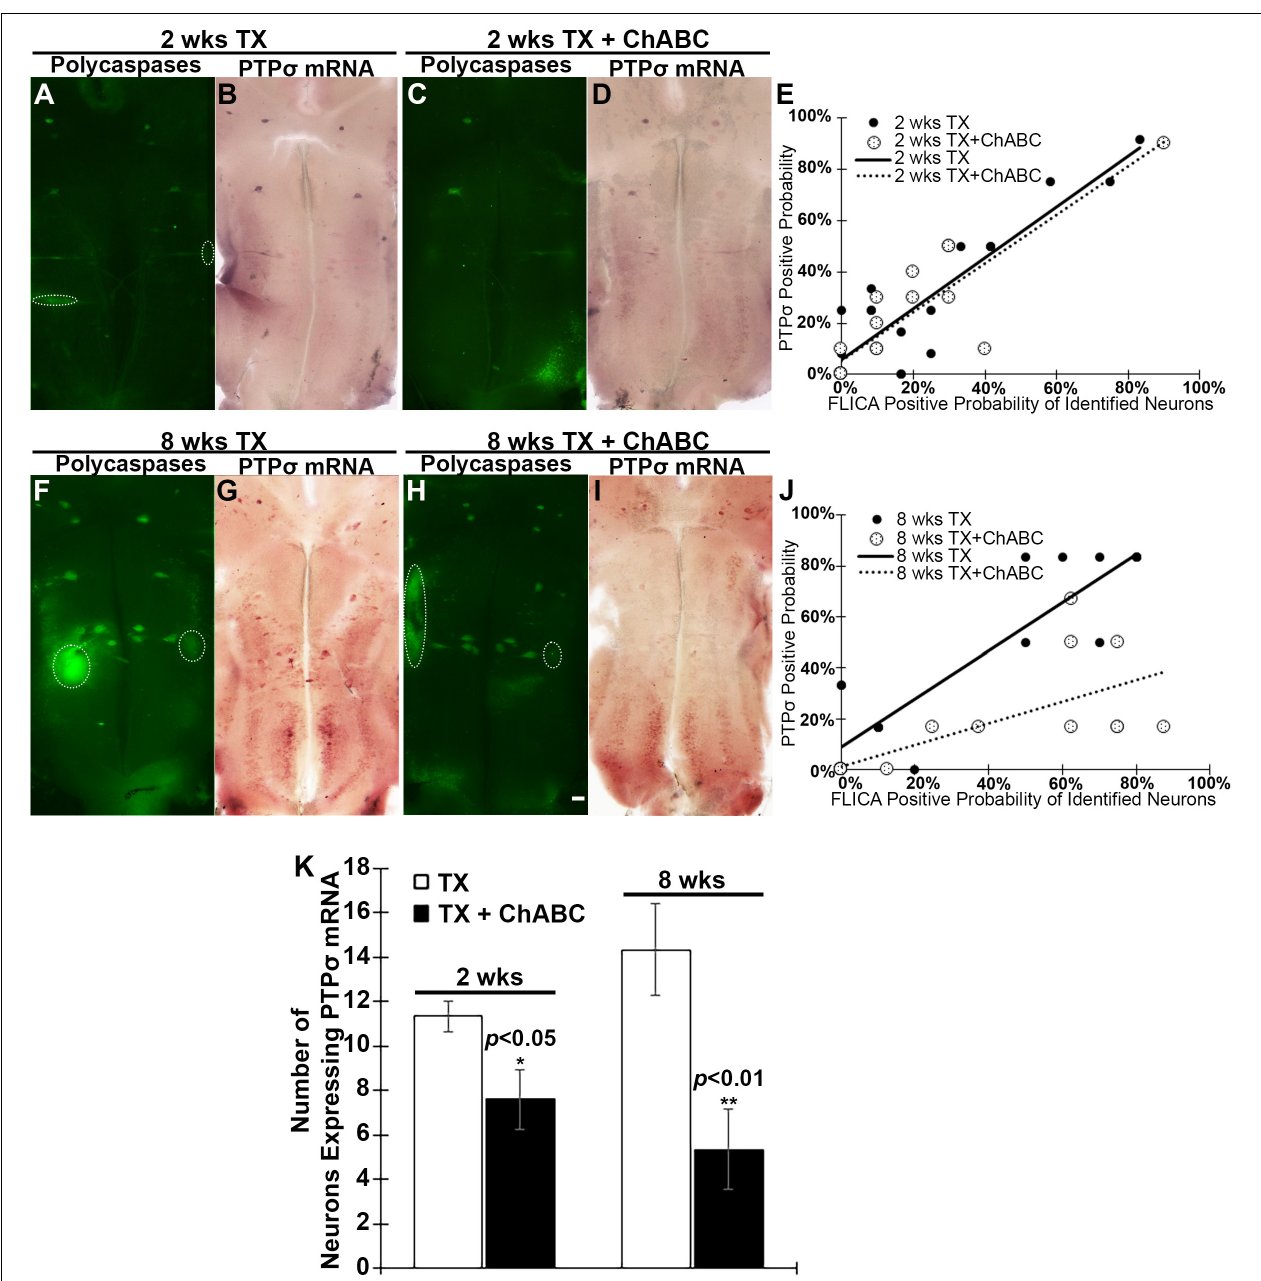
FIGURE 5 | ChABC reduces PTP σ mRNA expression in brain at 2 and 8 weeks post-transection. At 2 weeks post-TX, ChABC reduced caspase activation ( A vs. C ), and also reduced the number of neurons expressing PTP σ mRNA ( B vs. D ). (E) PTP σ mRNA expression correlated strongly with FLICA in RS neurons at 2 weeks post-TX, both with control enzyme buffer treatment ( r = 0.8886, p < 0.001) and with ChABC ( r = 0.8729, p < 0.001). The effect of ChABC on caspase activity disappeared at 8 weeks post-TX ( F vs. H ), but the number of neurons expressing PTP σ mRNA was still reduced ( G vs. I ). (J) At 8 weeks post-TX, there was a strong correlation between PTP σ mRNA and FLICA in identified RS neurons, both with control enzyme buffer ( r = 0.8985, p < 0.001) and with ChABC treatment ( r = 0.7145, p < 0.001). (K) The number of identified RS neurons expressing PTP σ mRNA was reduced greatly by ChABC treatment at 2 and 8 weeks post-TX. Circles outline cranial motor nuclei, whose neurons rapidly become caspase positive when they are axotomized during brain dissection. * p < 0.05, ** p < 0.01, n = 5 lampreys per group. Error bars: SEM. Scale bar: 200 µ m.